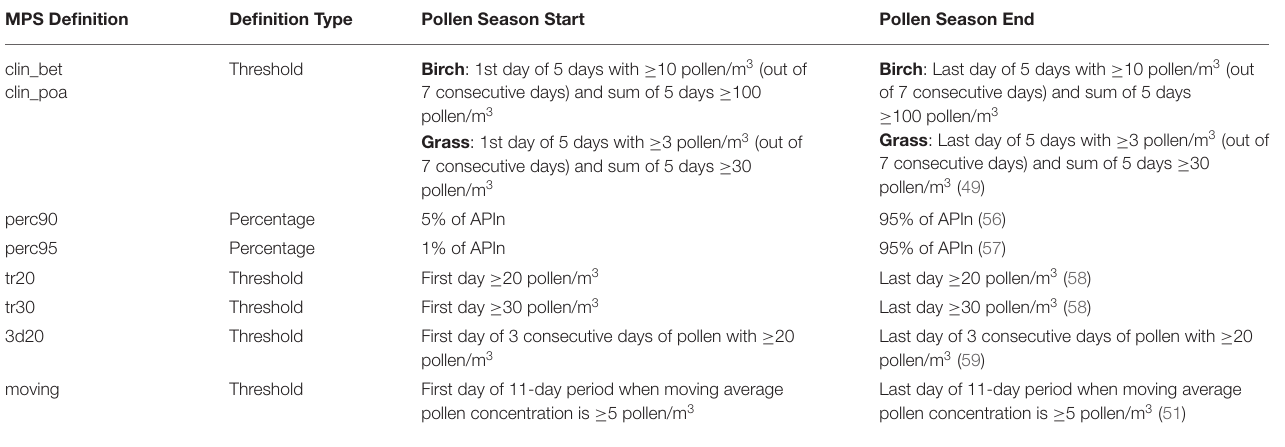
TABLE 1 | List of the eight definitions used to determine start and end dates of the main pollen season